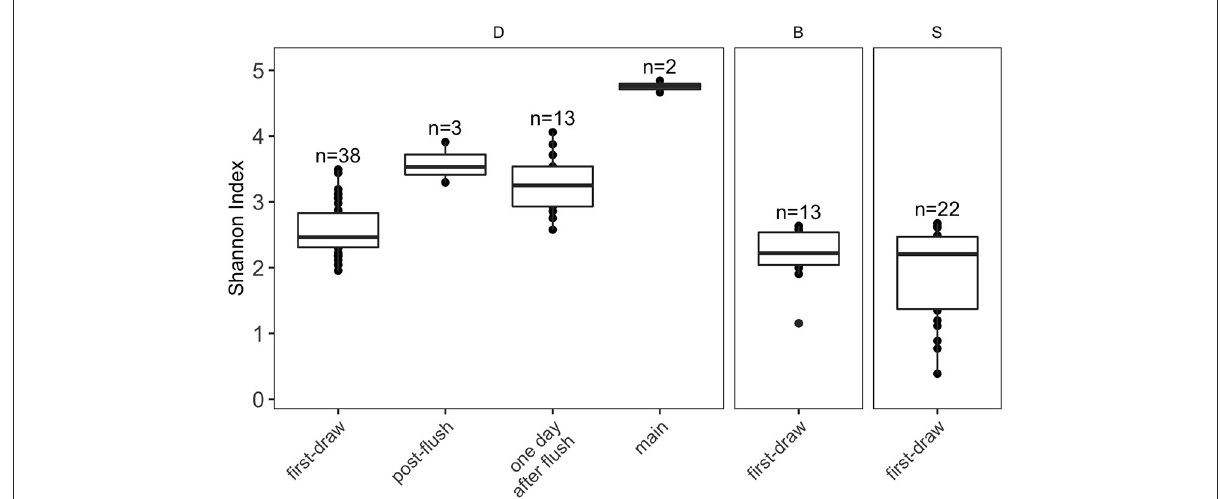
FIGURE4 Boxplots of alpha diversity metric Shannon Index. Plots are faceted by buildings (D, academic; B and S, residence halls). Box edges correspond to the first quartile, median, and third quartile. Whiskers extend from the edge to the largest and smallest values no further than 1.5 × the interquartile range from the edge. Data beyond the whiskers are considered outliers and plotted